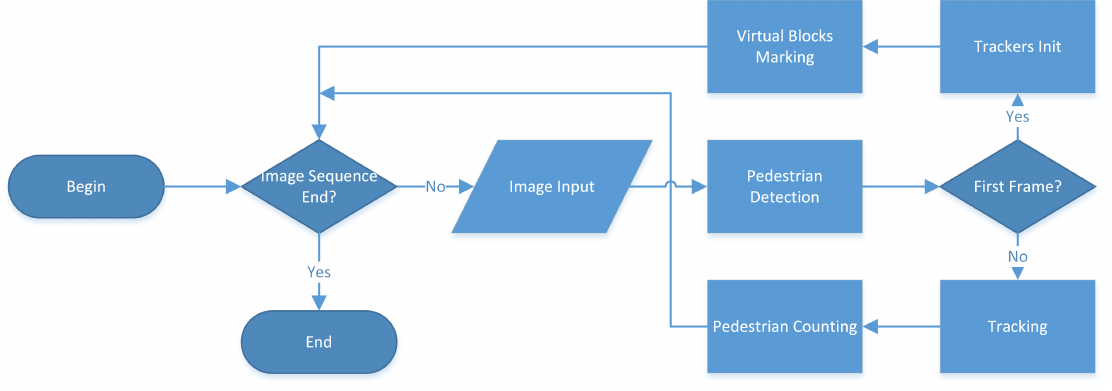
Figure 1. Overall flow chart of the proposed algorithm.